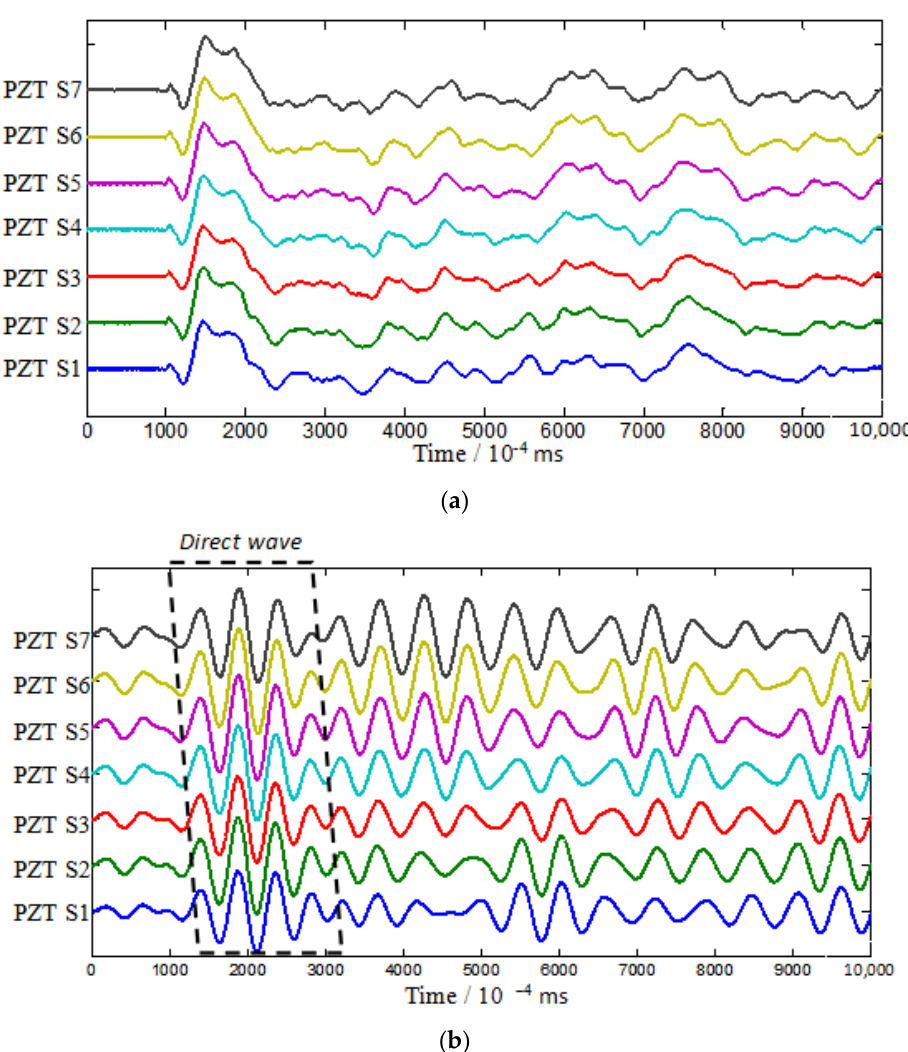
Figure 8. ( a ) Raw signal without filtration; ( b ) CWT filtering of the 4.1 kHz frequency component. To investigate the gain-phase errors’ effects on Lamb waves, the Gabor wavelet was chosen to extract the wavelet envelope curves at a specific frequency. The array